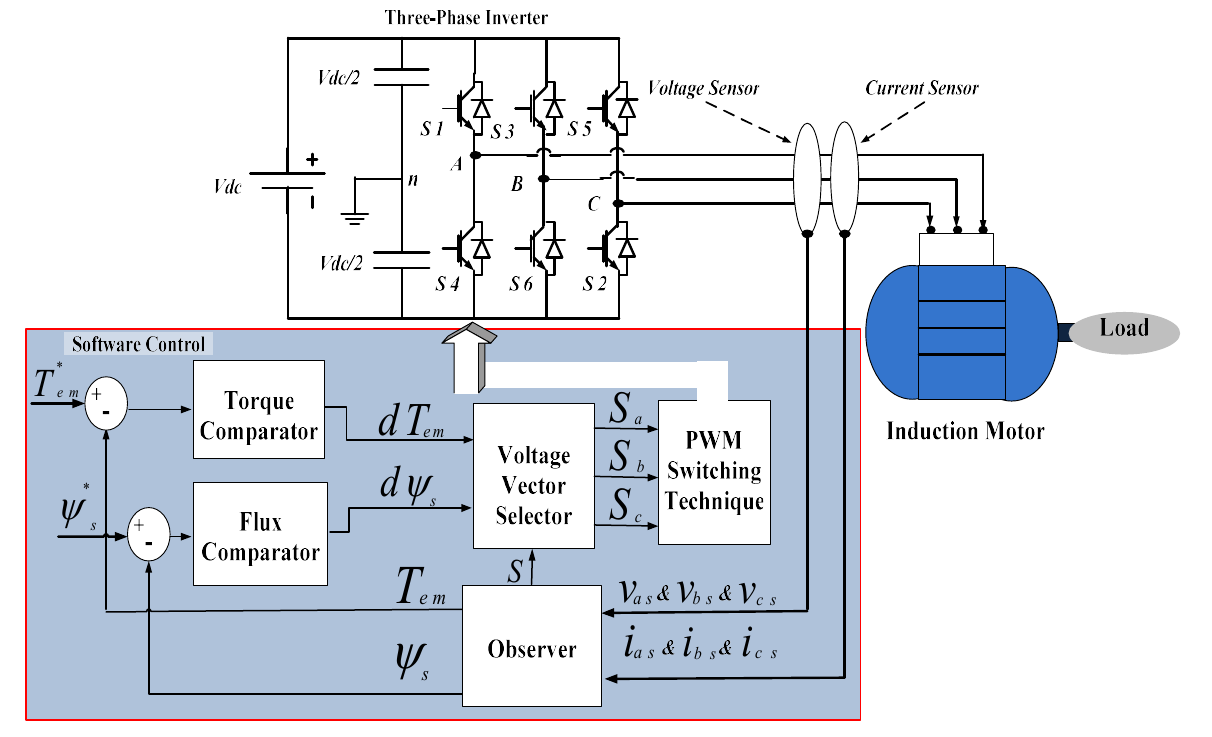
Figure 11. Block diagram of DTC for IM drive.